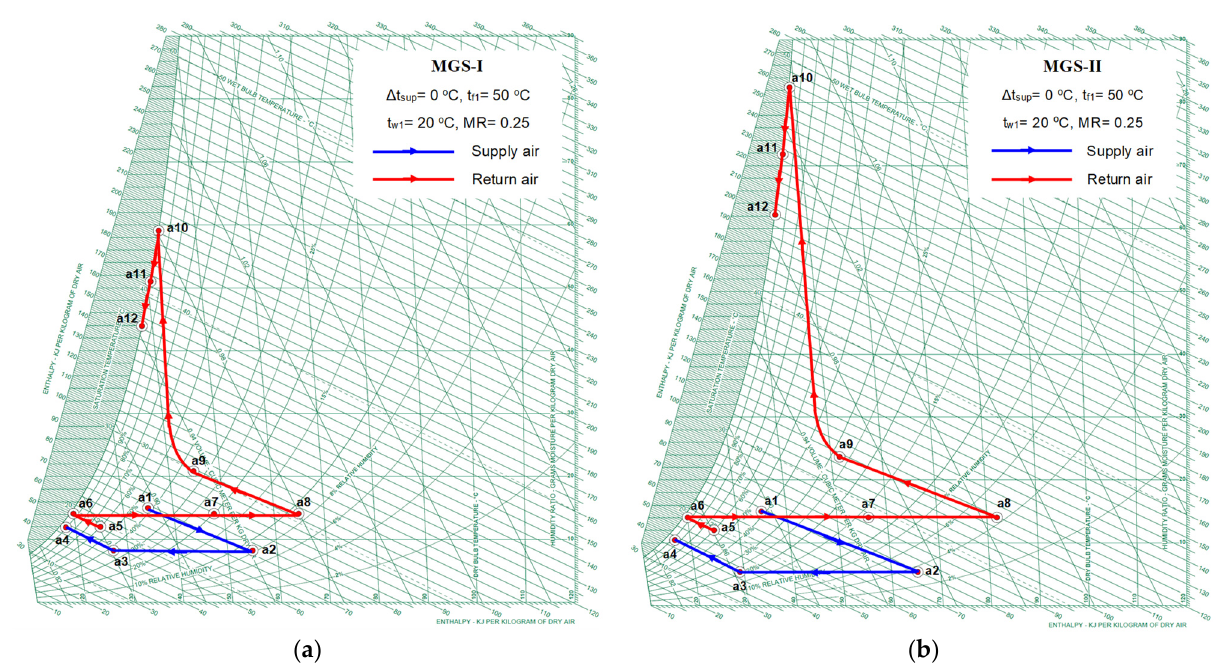
Figure 2. Psychrometric cycles of proposed multi-generation: ( a ) MGS-I; ( b ) MGS-II.